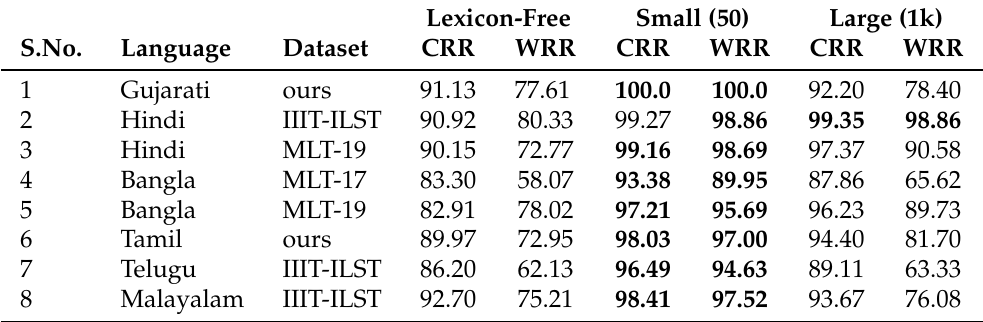
Table 6. Results of lexicon-based transcription on real datasets. In the parenthesis, ‘50’ and ‘1 K’ indicate the lexicon